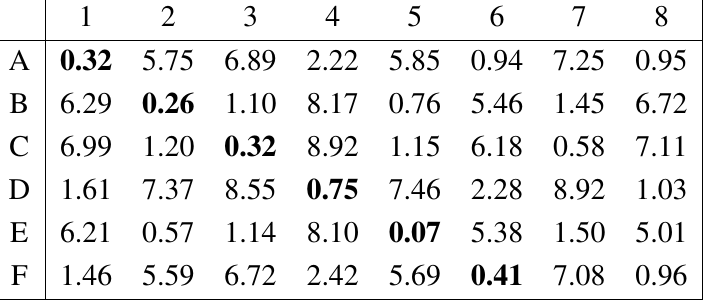
Table 2. Simple Angle Descriptor Similarity. This table lists Euclidean distances in radians, between the proposed angle descriptors of detected features, shown in Figure 12. In each case, the correct match has very small descriptor